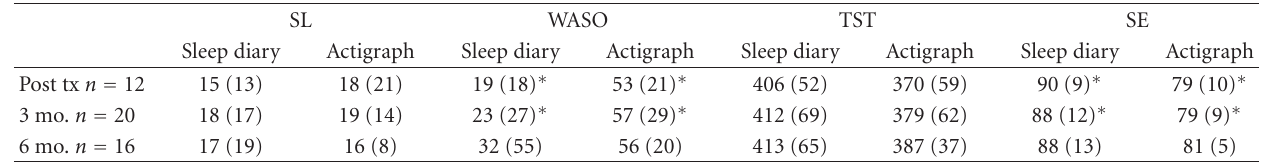
Table 2: Comparison of sleep diary and actigraphy: two-week mean (sd).